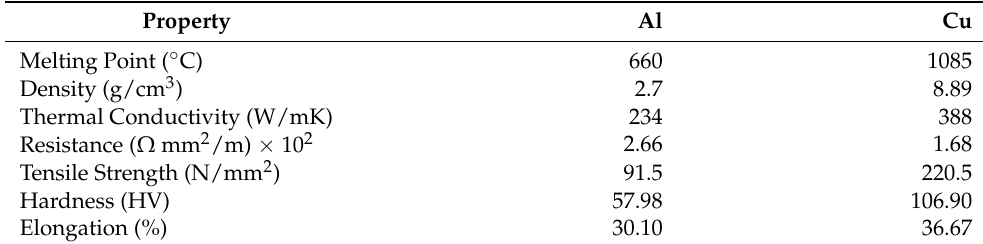
Figure 1. ( a ) Experimental setup for laser welding. ( b ) Dimensions of the welding specimen for the cross-section and tensile shear strength tests. Table 1. Physical and mechanical properties of base